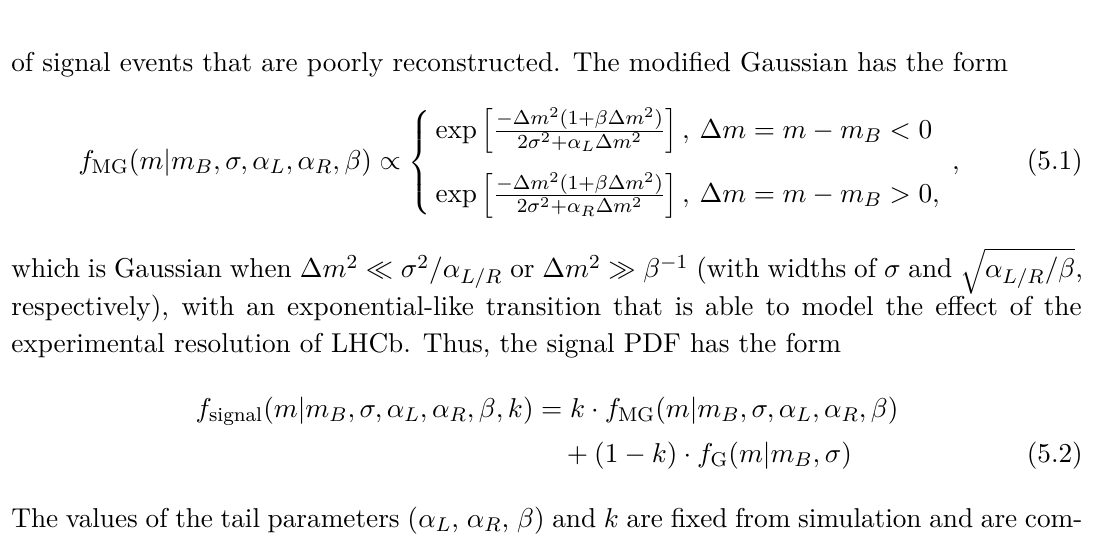
candidate is long S